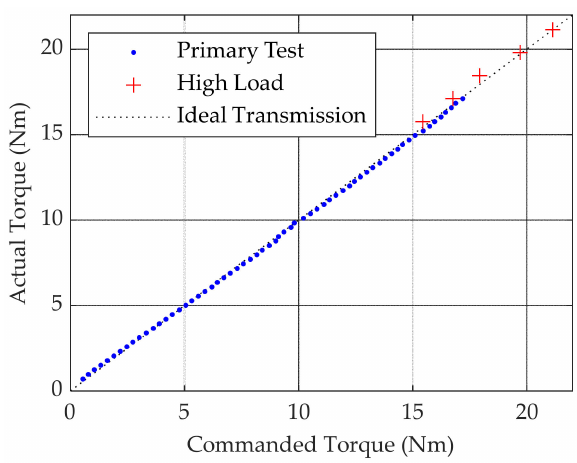
Figure 4. Static torque test, showing the actual vs. commanded torque from the actuator.